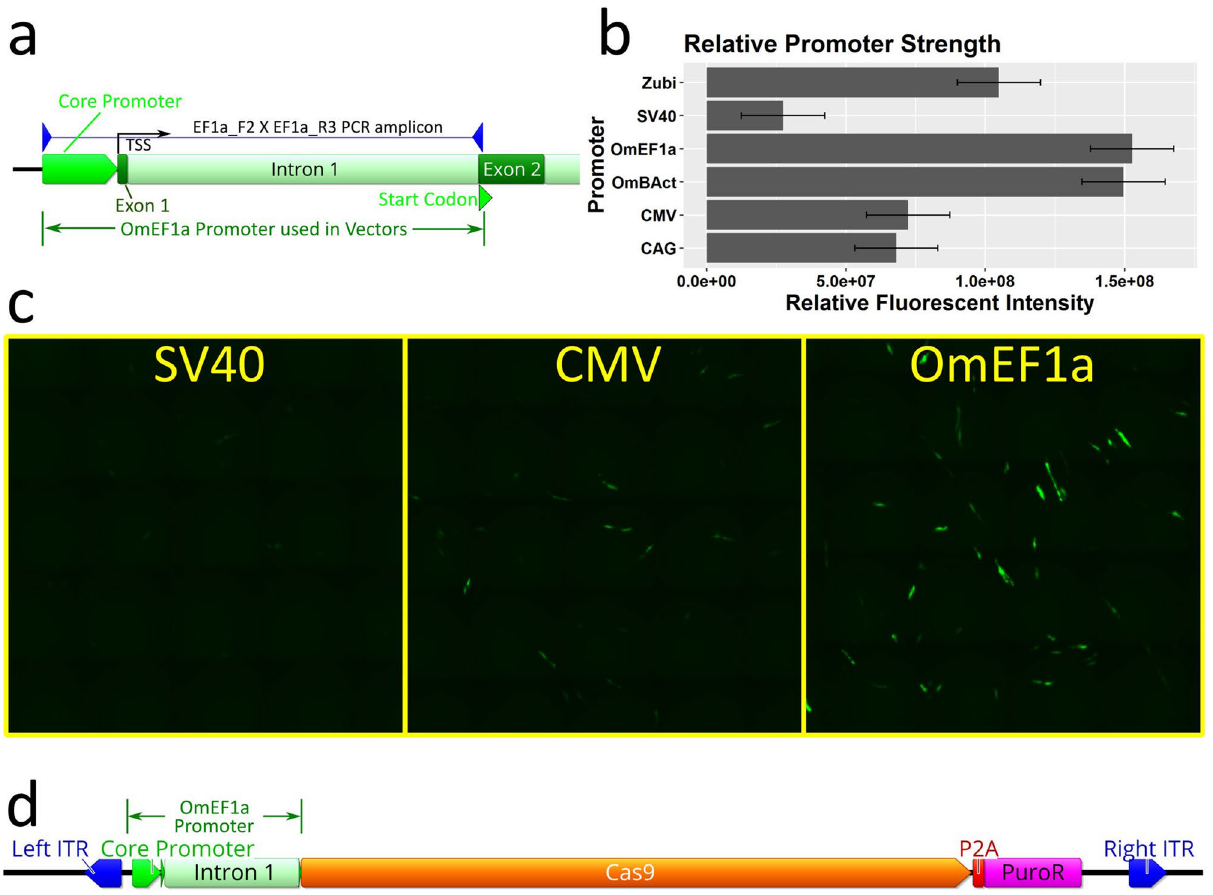
Figure 2. Isolation and selection of Polymerase II promoter for Cas9 expression in transposon plasmid vector. ( a ) PCR isolation of O. mossambicus endogenous promoters illustrated for EF1 alpha. The PCR amplicon spans ~ 150 bp upstream of the transcription start site, exon 1, intron 1, and part of exon 2 to the endogenous start codon. ( b ) Comparison of relative expression strength of candidate promoters for Cas9 quantified by fluorescent intensity of enhanced green fluorescent protein (EGFP). Data shown represent means ± SE (n = 2 per promoter) ( c ) Micrographs showing EGFP expression in OmB cells (green) from SV40, CMV, and OmEF1a EGFP vectors representative of those used for quantitative analysis ( d ) Plasmid map of transposon vector (OmEF1aCas9P2APuroSB) for generation of Cas9 cell line including OmEF1a promoter upstream of Cas9 and puromycin resistance coding sequences (separated by the P2A self-cleaving peptide sequence) in between the two Sleeping Beauty transposon internal terminal repeats (ITRs). Gene and vector maps were generated using Geneious 11.0.3 (Biomatters, https:// www. genei ous. com). Bar plot was generated using Rstudio 1.1.456 (https:// rstud io. com). Image editing and assembly into complete figures was performed using Inkscape 0.92